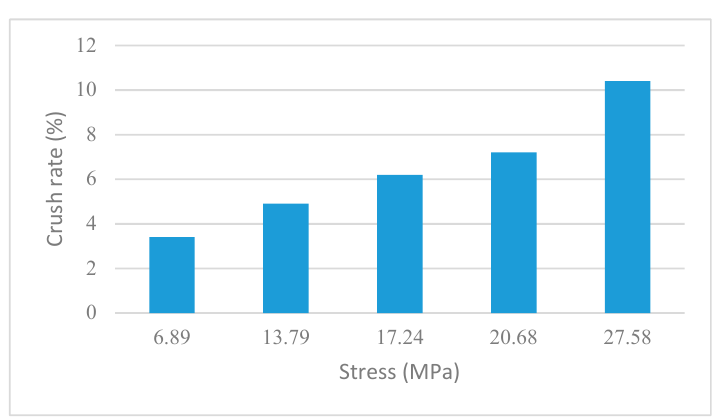
Figure 3. Crush rate with one loading cycle.